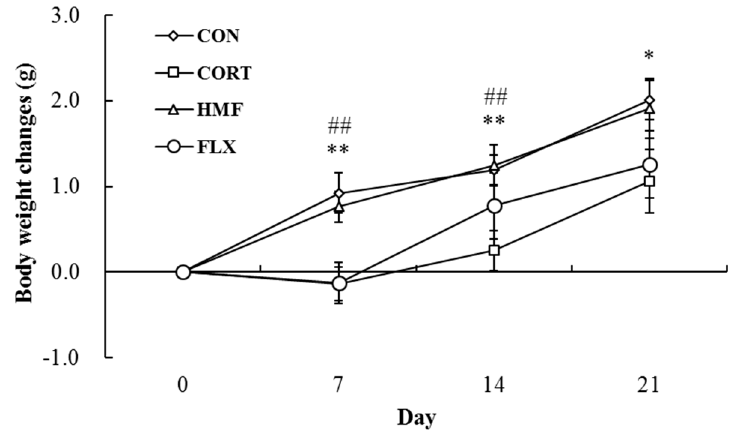
Figure 2. Body weight changes on Days 7, 14, and 21. Values are means ± SEM ( n = 8). Symbols show significant differences between the following conditions: CON vs. CORT (* p < 0.05, ** p < 0.01) and CORT vs. CORT + HMF ( ## p < 0.01).